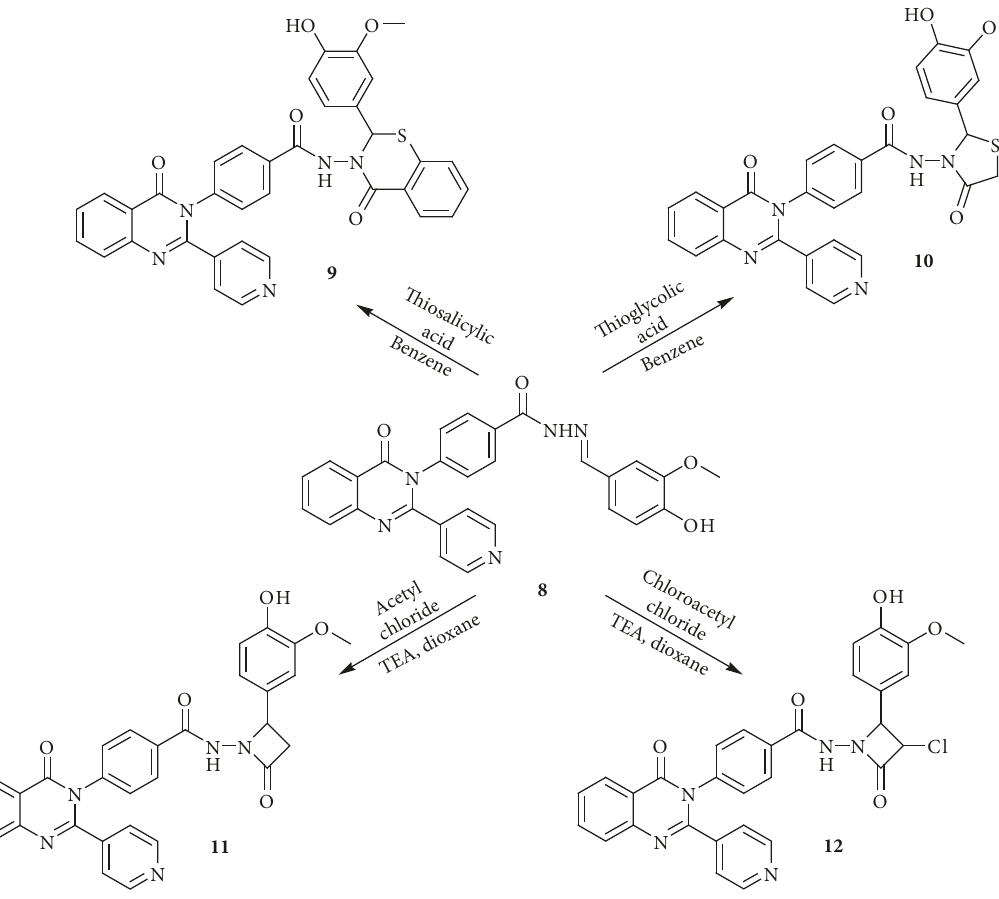
Scheme 3: Synthesis of compounds 9 – 12